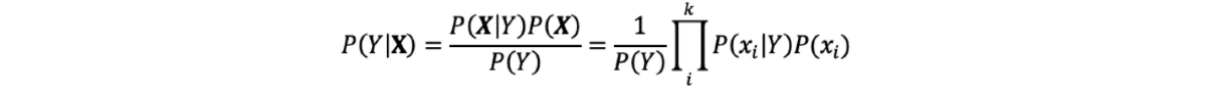
Figure 3. Naïve Bayes algorithm.